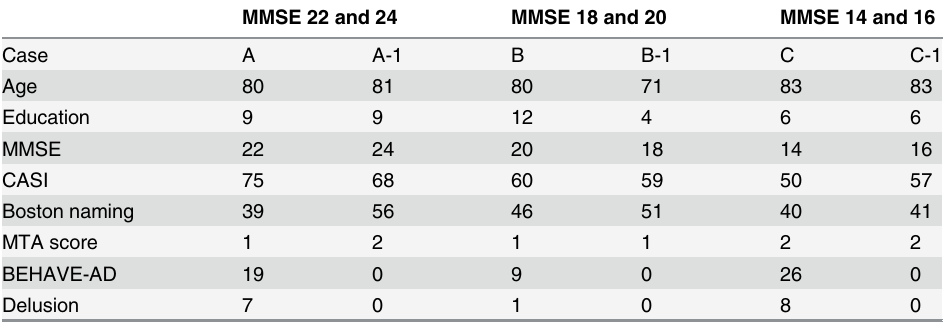
Table 2. Demographic characteristics for MMSE-matched pairs of the multilingual and bilingual AD